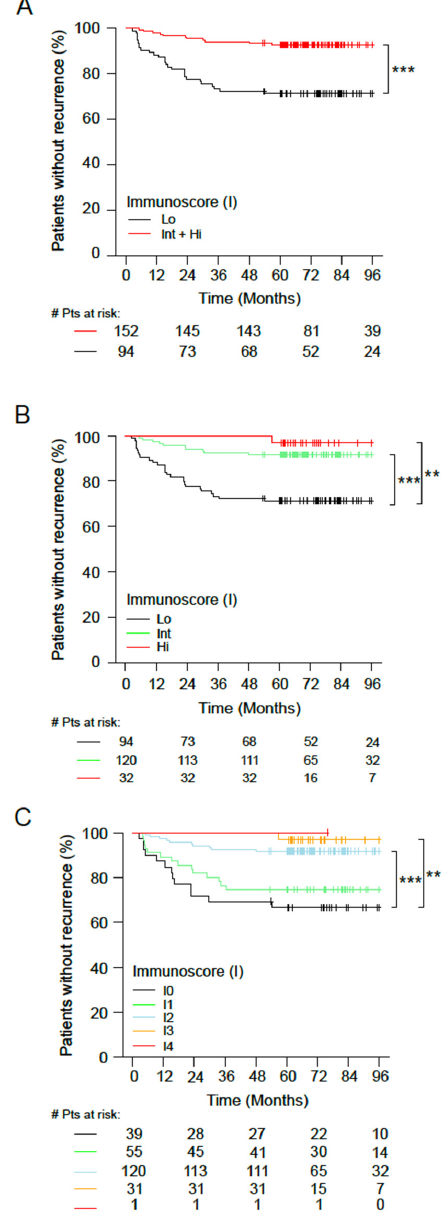
Figure 3. The outcomes of stage I–III microsatellite-stable (MSS) colon cancer according to Immunoscore. ( A – C ) Kaplan–Meier curves of Immunoscore for stage I–III MSS patients are shown for TTR. ( A ) Two Immunoscore categories: Lo (0–25%, black) and Int+Hi (>25–100%, red). (B ) Three Immunoscore categories: Lo (0–25%, black), Int (>25–70 %, green), and Hi (>70–100 %, red). ( C ) Five Immunoscore categories: I0 (0–10%, black), I1 (>10–25%, green), I2 (>25–70%, azure), I3 (>70–95%, orange), and I4 (>95–100%, red). Significant log-rank p -values are marked as *** p < 0.005 and ** 0.005 ≥ p <